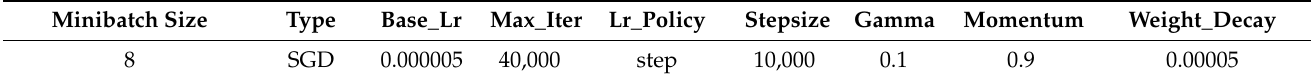
Table 3. The hyper-parameter values used in the mini-batch SGD.